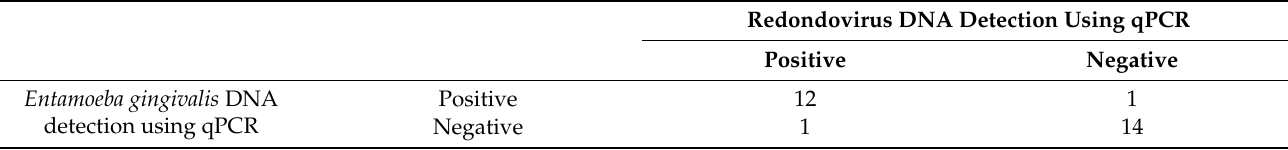
Table 2. Correlation between redondovirus and Entamoeba gingivalis DNA detection using real-time PCR. Redondovirus DNA Detection Using